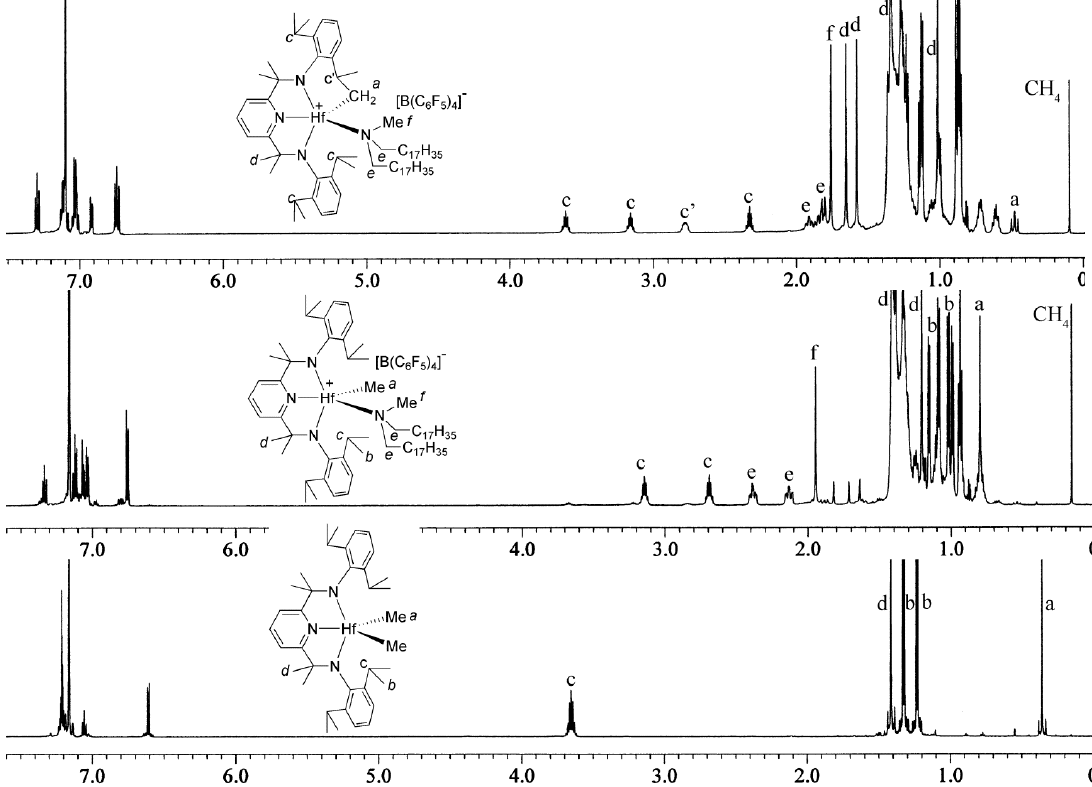
Figure 3. Thermal ellipsoid plot (30% probability level) of 22 (a) and 25 (b). Hydrogen atoms are omitted for clarity. Selected bond distances (Å) and angles ( o ) in 22 (a): Hf-N(1), 2.296(10);